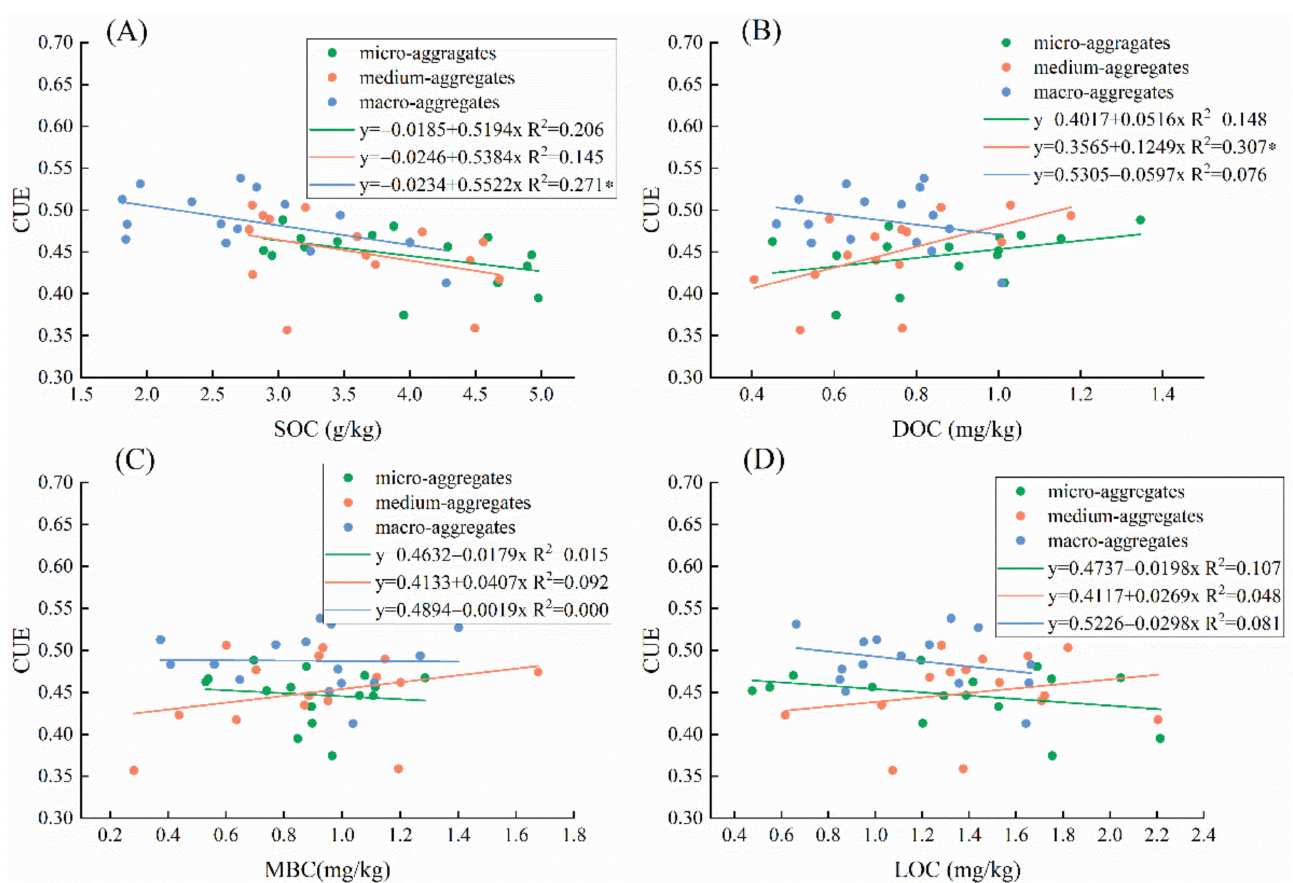
Figure 2. Relationship between four carbon components and microbial carbon use efficiency in three aggregate sizes. The scatter subplot in each panel ( A – D ) demonstrates the relationship between carbon components (SOC, DOC, MBC, and LOC, respectively) and CUE. Different colors (green, orange, and blue) represent different aggregates (micro-aggregates, medium aggregates, and macro- aggregates, respectively). The formula corresponding to each aggregate and R 2 is shown. * indicates significance at the level of p <